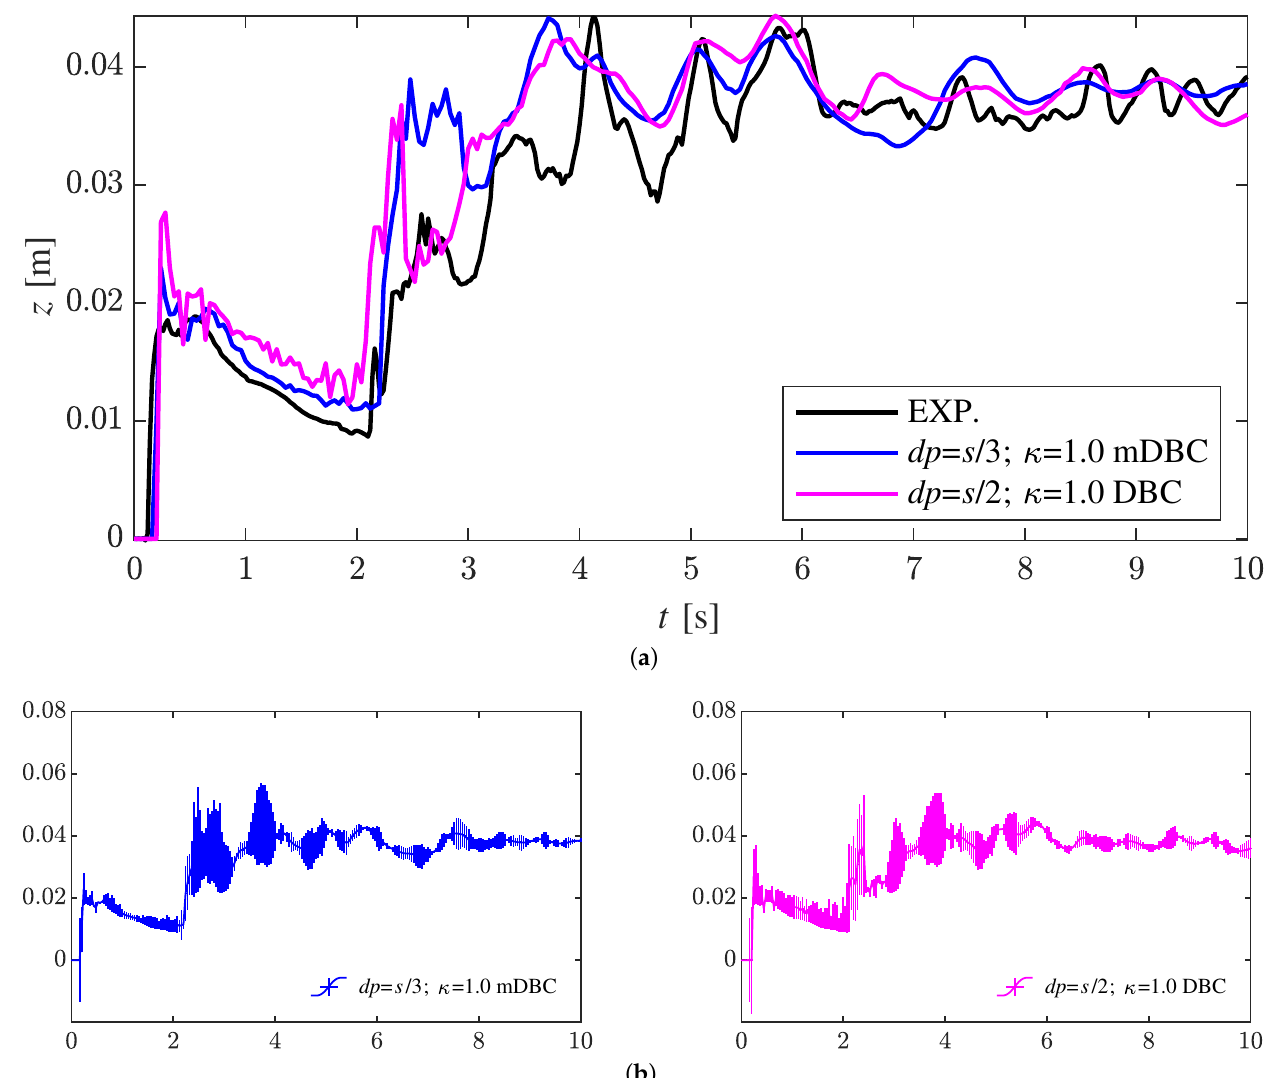
Figure 8. General comparison at P2 ( a ) and relative local elevation error ( b ); same κ value but different resolutions and